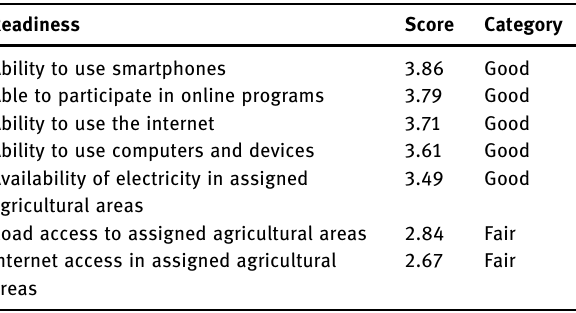
Table 6: Extension workers ’ level of readiness related to the use of SFT